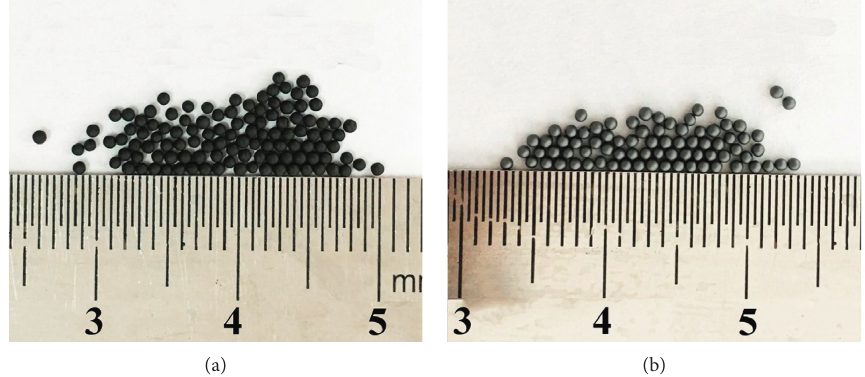
Figure 1: TRISO particle samples (a) with the OPyC layers and (b) without the OPyC layers.